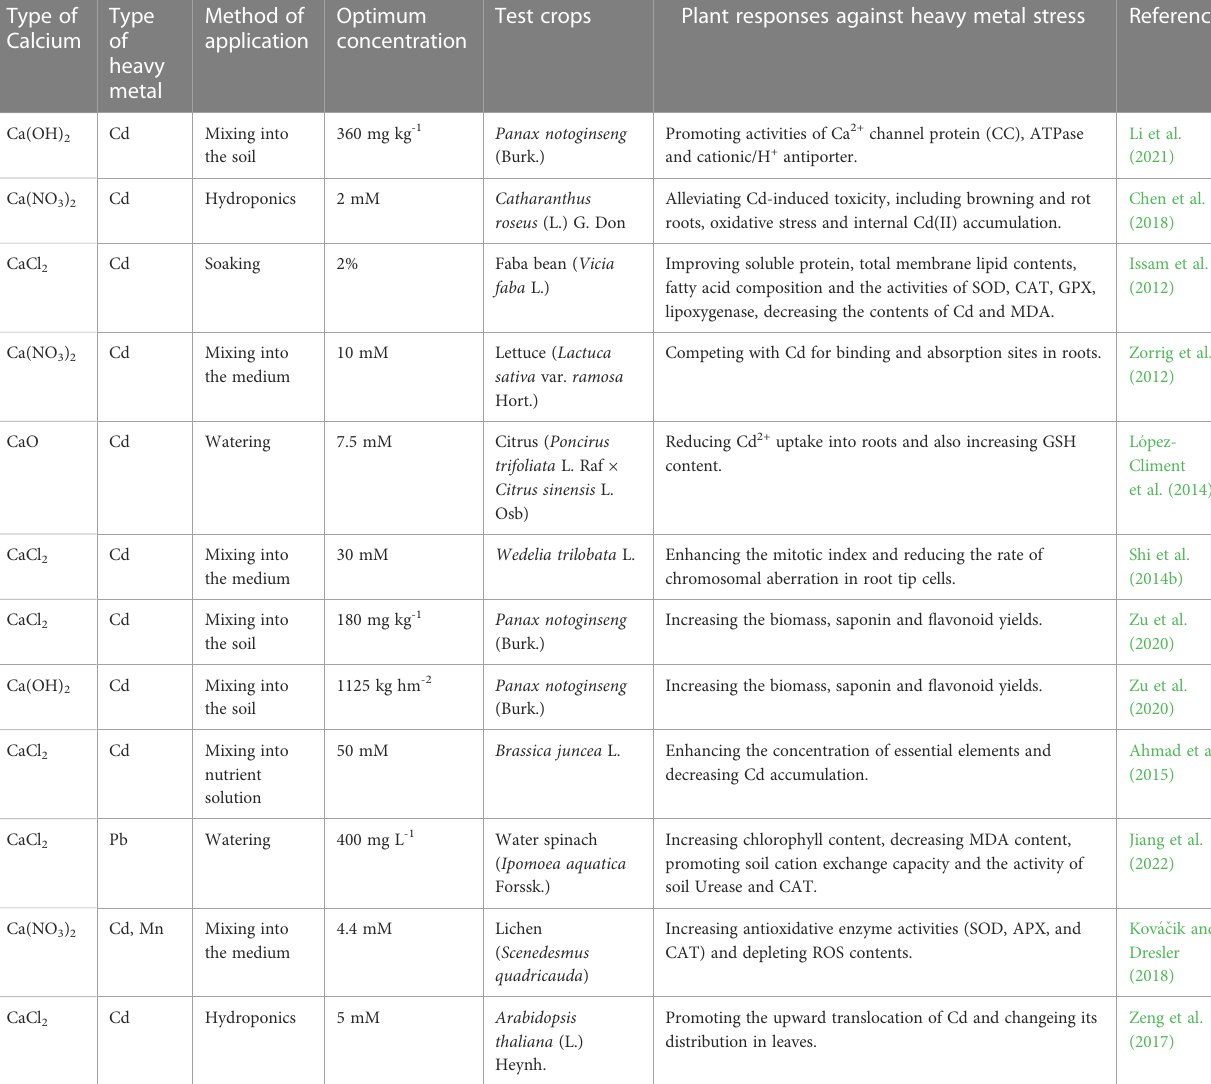
TABLE 6 List of optimal concentrations of exogenous calcium used to alleviate heavy metal stress in different